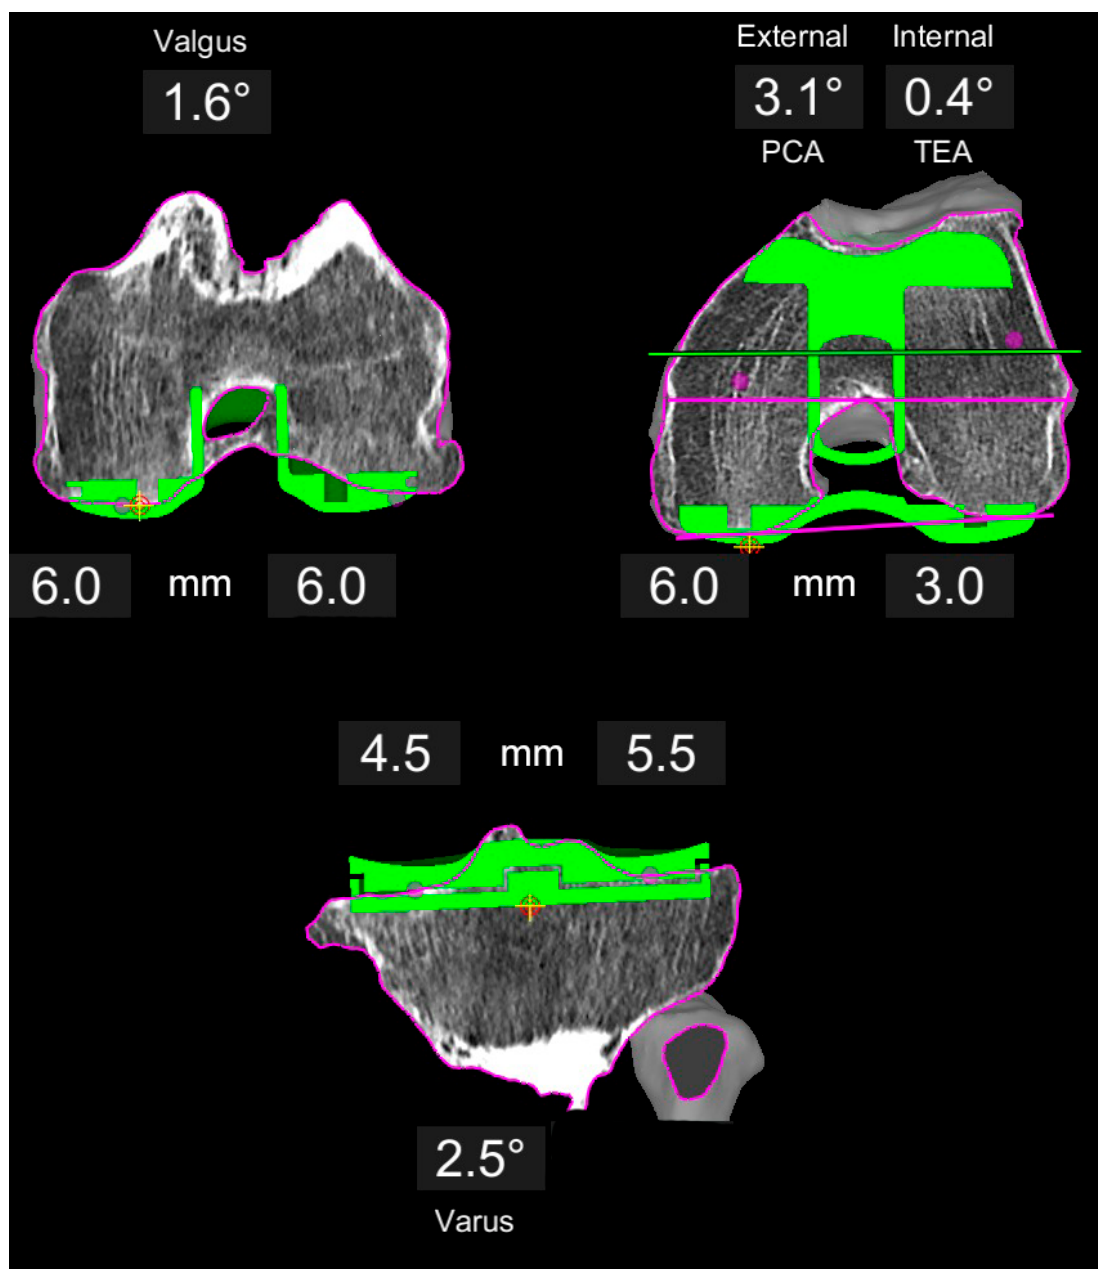
Figure 2. Example of a varus knee planned with restricted KA. The distal femoral resection is symmetric at 6 mm, whereas the posterior resection is adjusted to co-align the trochlea groove close to the native trochlea axis. This results in a 3.1 ◦ external rotation with respect to the PCA. Tibia follows the same principle as for KA (Figure